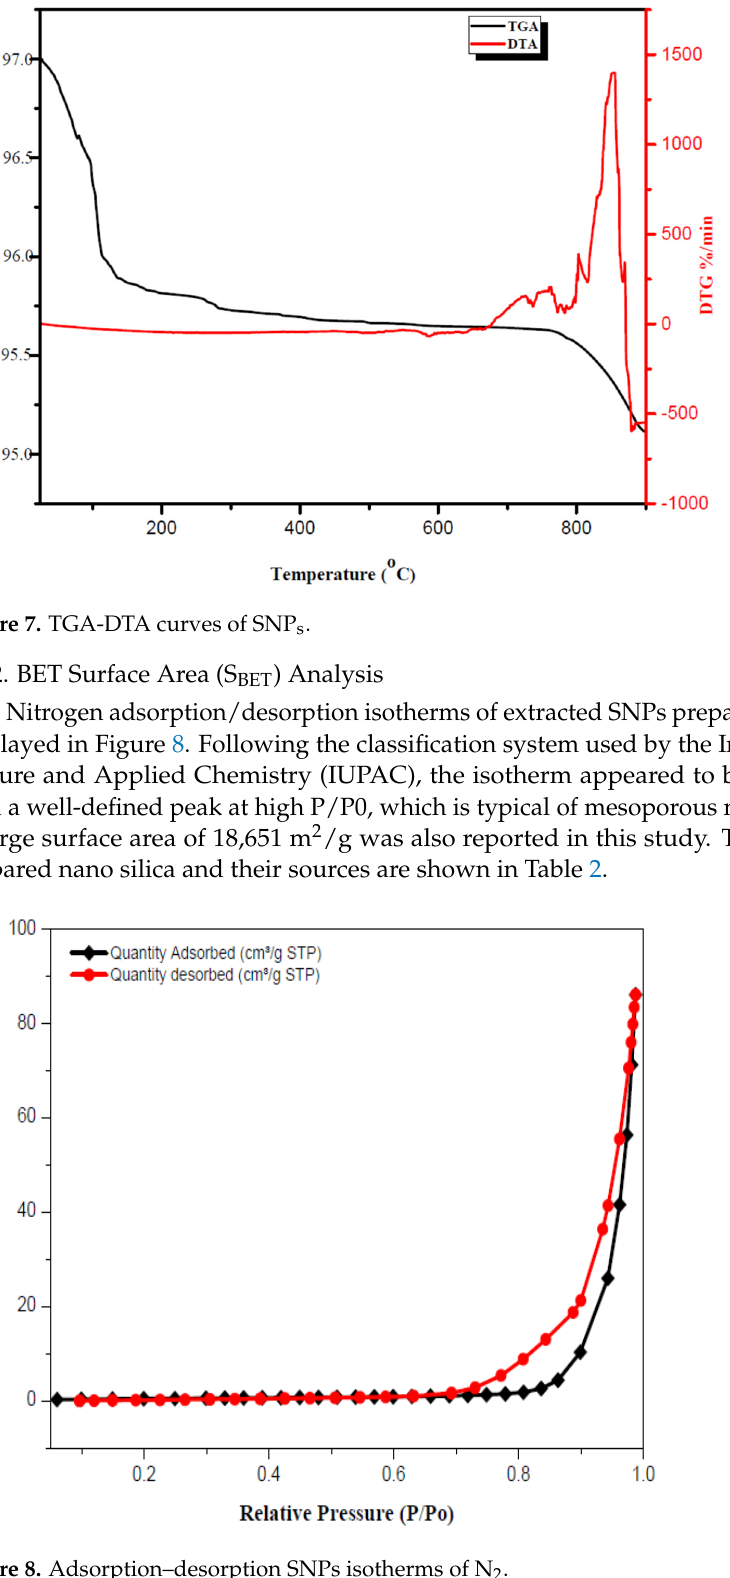
Figure 8. Adsorption–desorption SNPs isotherms of N2. Table 2. Surface area of previously prepared nano silica.